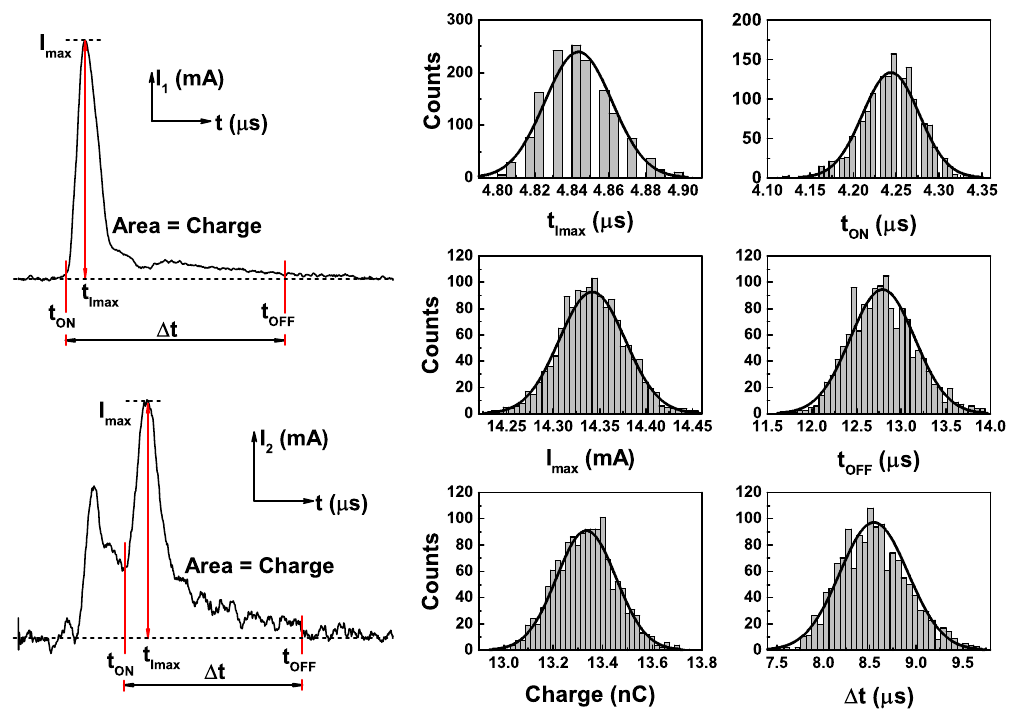
Figure 2. Details of estimated parameters for the currents I 1 and I 2 observed during the rising edge of the high voltage (HV) pulses ( left side ) and typical histograms of all parameters for 1419 consecutive frames, with superimposed normal distribution curves ( right side